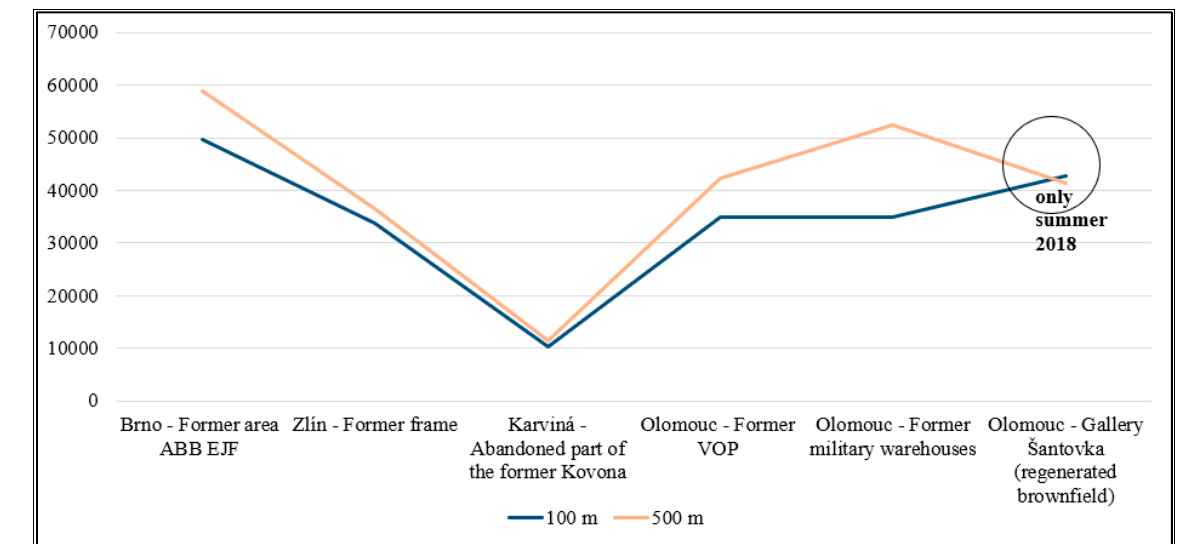
Figure 6. Average real estate prices (in CZK/m 2 ) in the neighbourhoods of the surveyed brownfields. Source: own proceeding-based data from www.ceskereality.cz (accessed between 4 February 2017 and 7 December 2019).